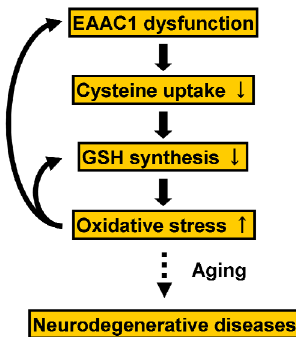
Figure 2. Possible mechanism of neurodegenerative diseases caused by GSH depletion via EAAC1